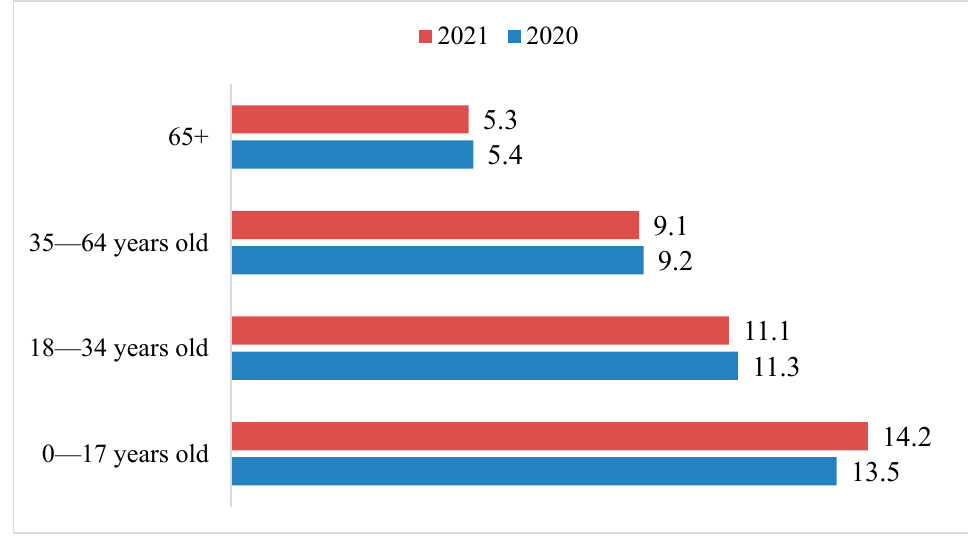
Figure 2. Poverty rate trends among households and individuals, 2020–2021. Source: own elaboration on the Istat database.